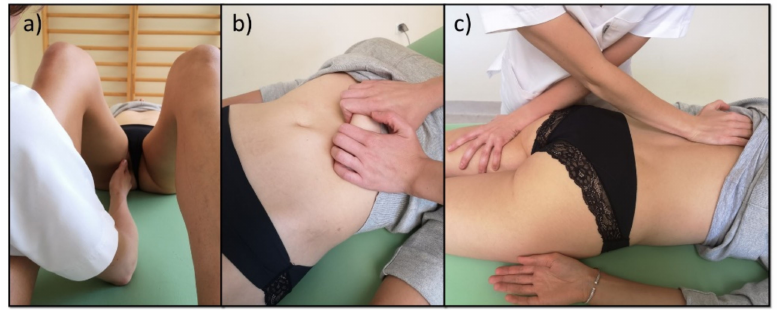
Figure 3. ( a ) Pelvic floor release; ( b ) stretching of breathing diaphragm; ( c ) release of the limbs with breathing diaphragm.